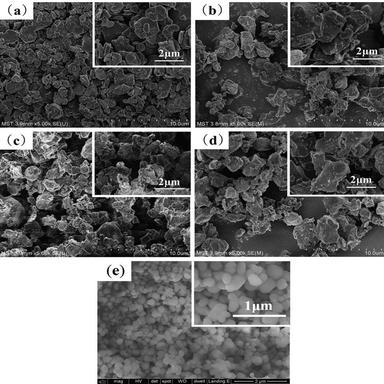
SEM images of samples: (a) U-MT, (b) Si69-MT, (c) KH570-MT, (d) SA-MT and (e) TiO2 particles.